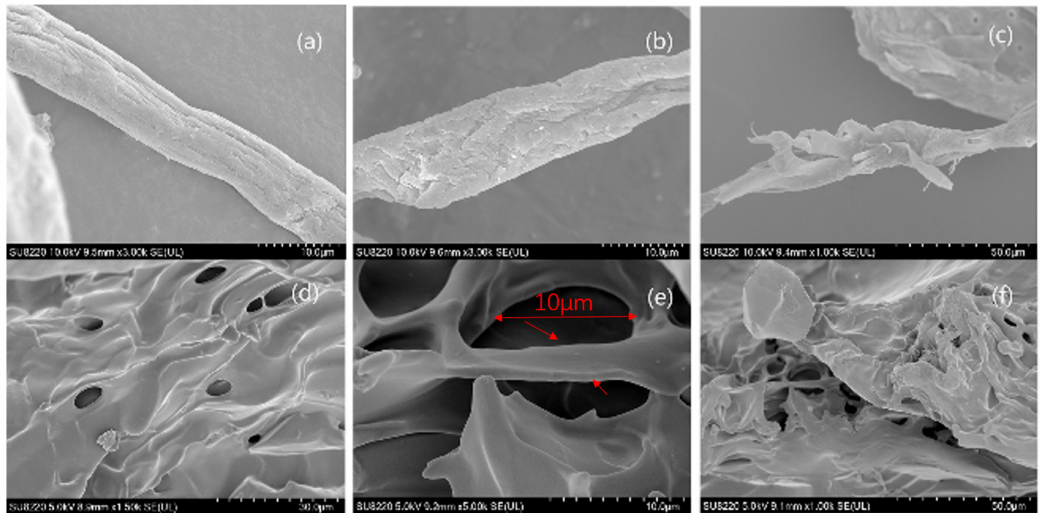
Figure 2. SEM images of ( a ) cellulose; ( b ) SBC; ( c ) P-SBC; ( d , e ) S-CH and ( f ) P-CH.